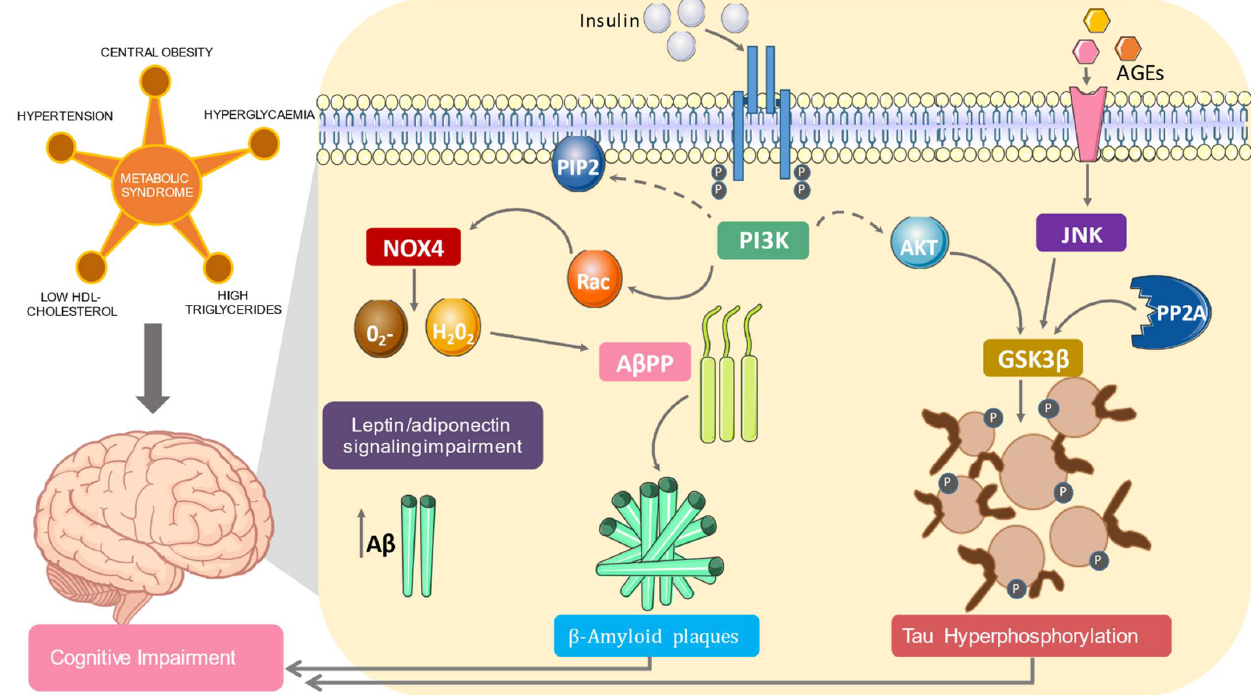
Figure 1. Impact of metabolic syndrome on cognitive impairment. PIP2: phosphatidylinositol bisphosphate; AKT: protein kinase B; PI3K: phosphoinositide kinase-3; JNK: c-Jun N-terminal kinase; AGEs: advanced glycation end products; PP2A: protein phosphatase 2A; GSK3β: glycogen synthase kinase 3 beta; NOX4: NADPH oxidase 4; 02-: superoxide; H 2 0 2 : hydrogen peroxide; Aβ: amyloid beta. Solid lines mean activation; dashed lines mean inactivation.